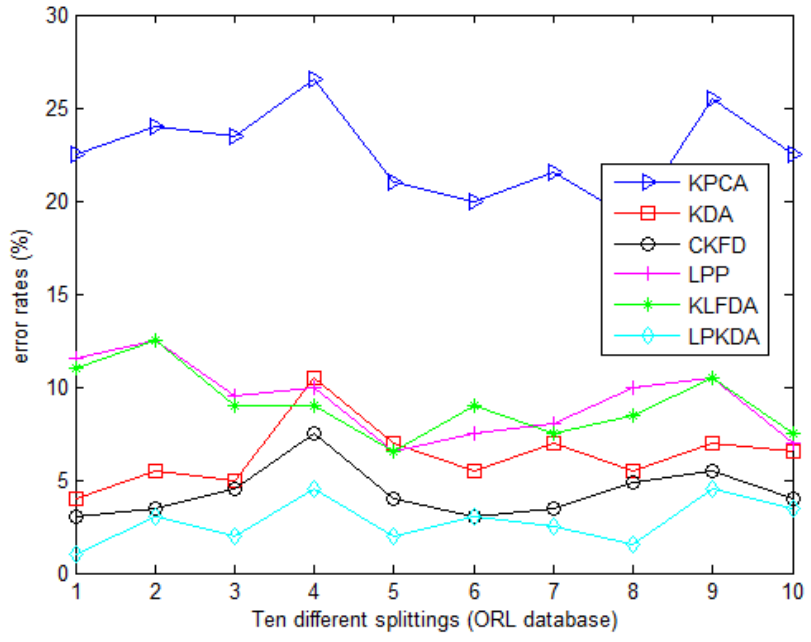
Fig.2. Comparison of KPCA, KDA, CKFD, LPP, KLFDA, and LPKDA in error rates on three face